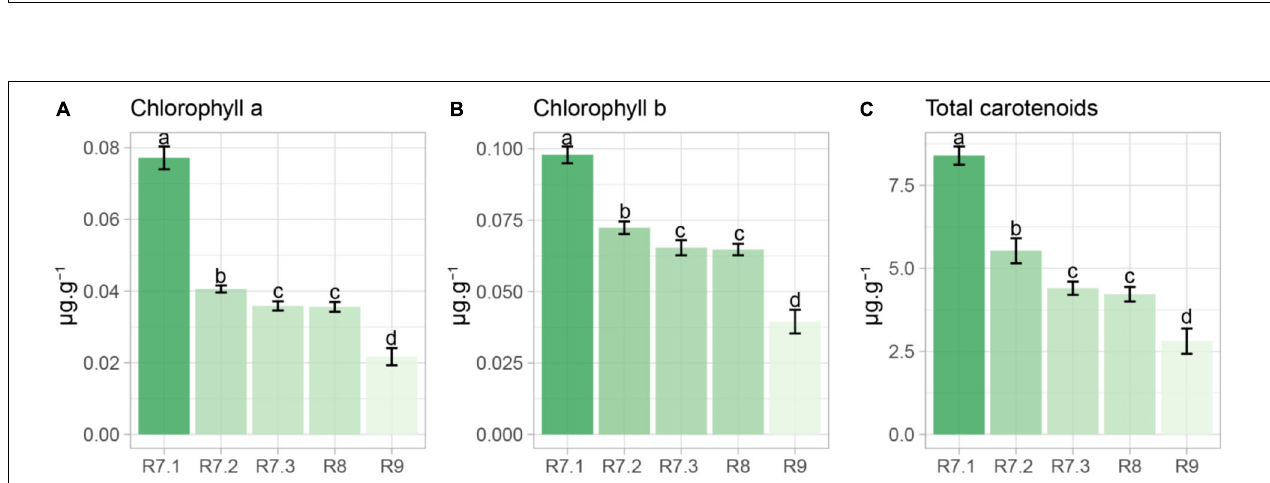
FIGURE 3 | Chlorophyll a , chlorophyll b and total carotenoids in soybean seeds from different maturation stages. Each bar represents the mean of four replicates ± standard deviation. Different letters indicate significant difference ( α = 0.05) by Tukey test ( n = 20).